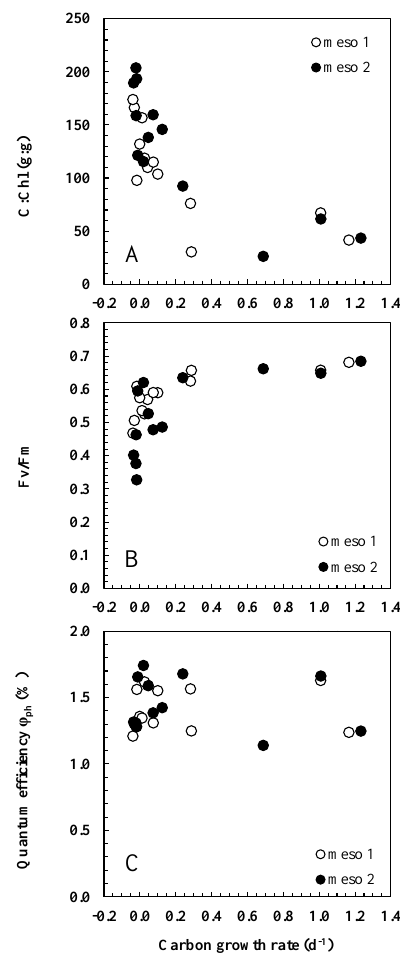
Figure 7. Three proxies for growth rate as a function of measured carbon growth rate (µ POC , d − 1 ) : (a) carbon to chlorophyll a + c ra- tio (C:Chl a + c , gg − 1 ) , (b) Photosystem II efficiency (Fv / Fm) and (c) quantum efficiency ( ϕ ph , %). Data combined from both